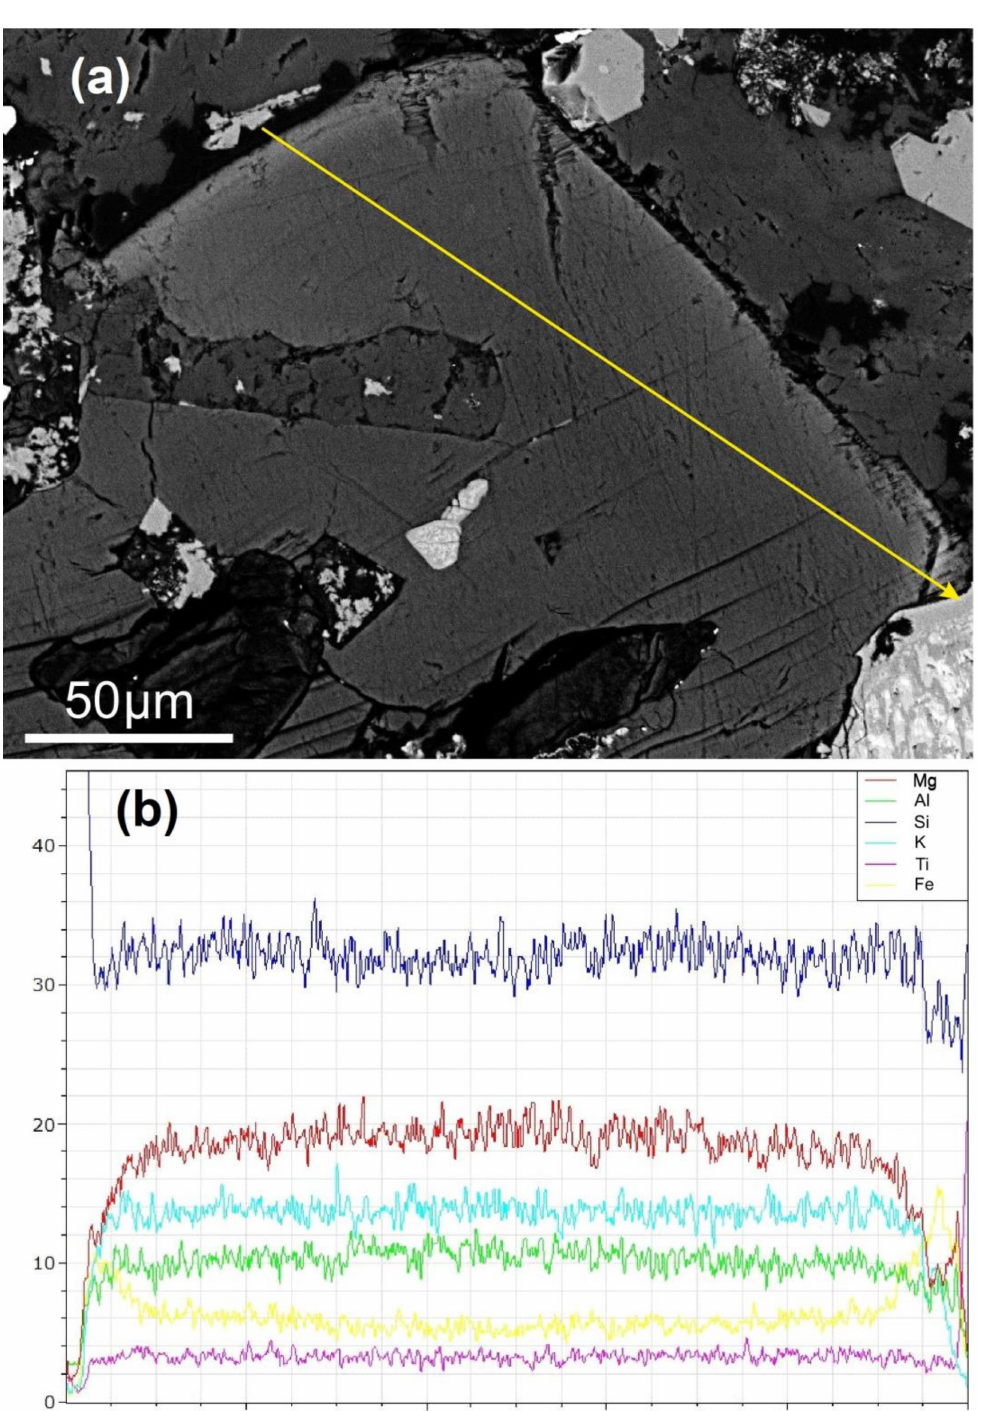
Figure 4. Compositional variations across zoned groundmass phlogopite ( a )—BSE image with profile location; ( b )—relative characteristic X-ray intensities for selected elements, showing the relatively lower Mg, Al and higher Fe concentrations in